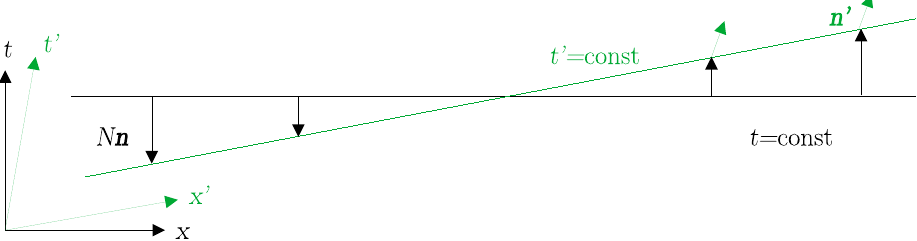
Figure 1. A Lorentz transformation in Minkowski space–time, shown in the traditional way by means of axes as well as in terms of linear normal deformations of a spatial slice. A slice t = const in the original coordinate system was transformed to a new spatial slice t (cid:48) = const by a linear deformation with position-dependent displacement N ( x ) = N 0 + vx along the unit normal vector field n